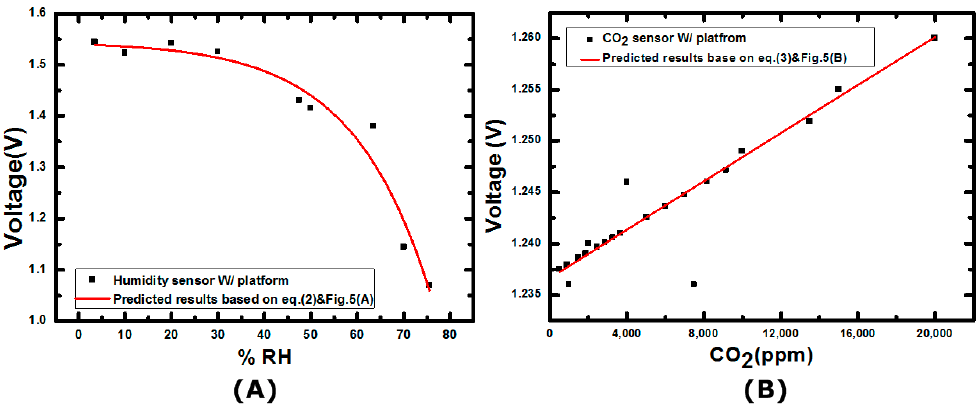
Figure 6. ( A ) Humidity and ( B ) CO 2 concentration measurement results from the developed sensing platform.